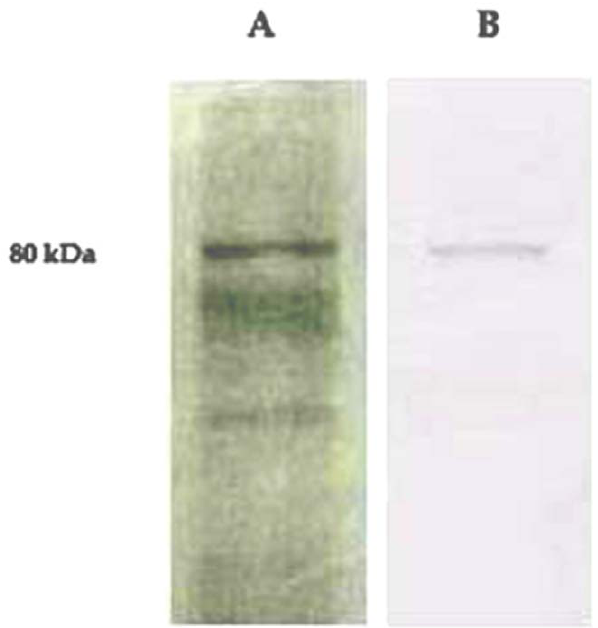
Figure 10. Determination of antibody specificity by Western blotting. A ) Gel pattern of epididymal plasma (30 m g) after DEAE- Cellulose Chromatography. B ) Western blotting of epididymal plasma after DEAE—Cellulose Chromatography.